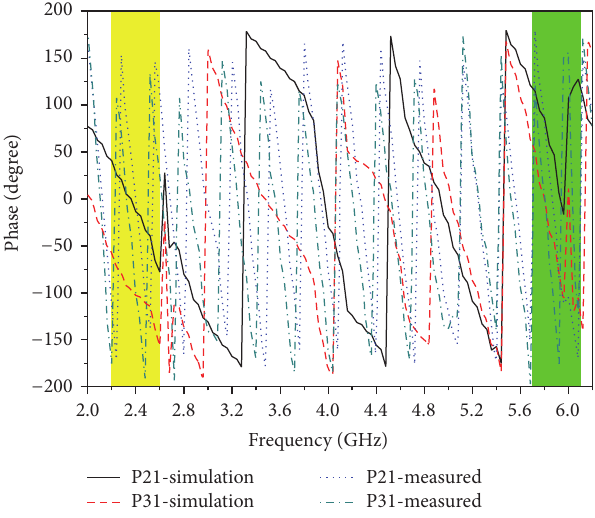
Figure 7: S11 and S41 of the coupler prototype and CKT model. Figure 8: S21 and S31 of the coupler prototype and CKT model.